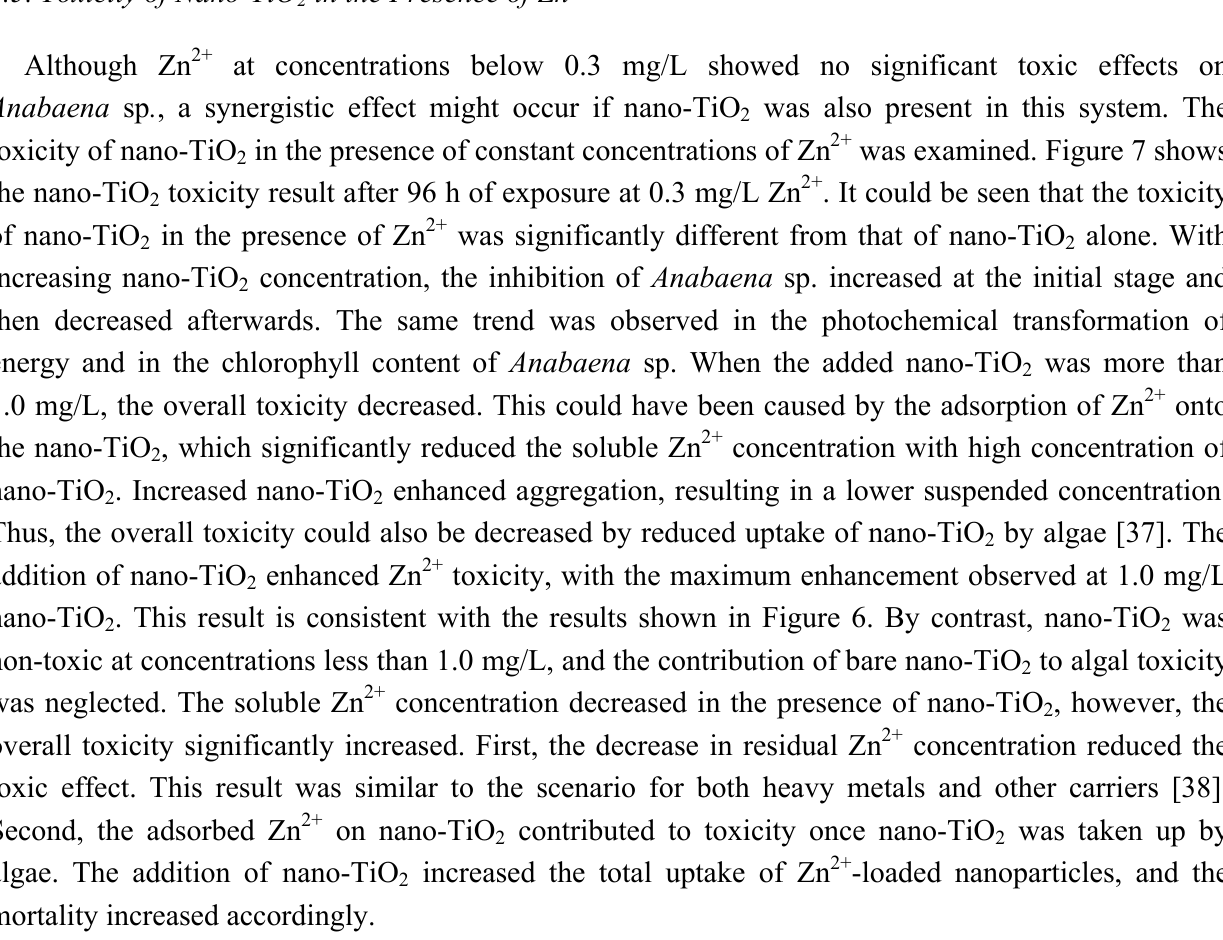
Figure 6. Toxic effect of Zn 2+ on the inhibition of Anabaena sp. with the fixed nano-TiO